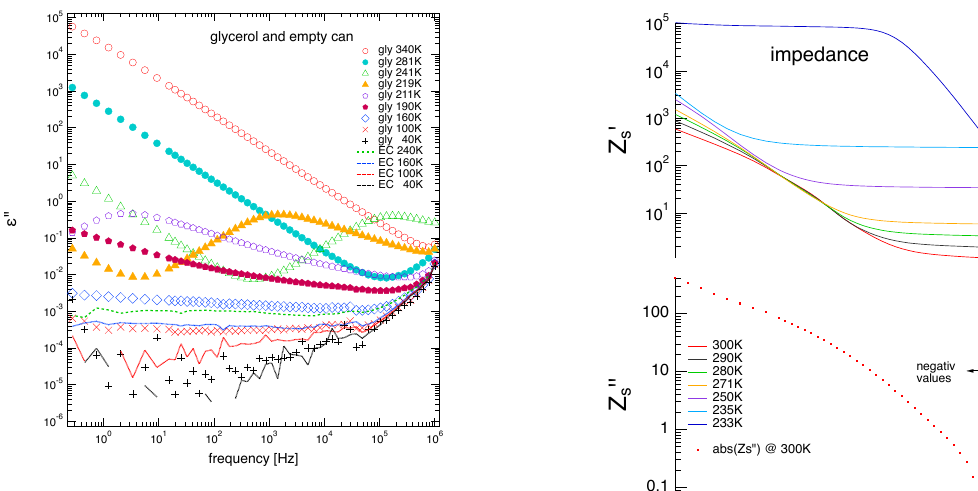
Figure 9. Dielectric scan on empty can (lines) and glycerol (symbols) for comparison are shown at several temperatures (see legend; same colour indicates same temperature).